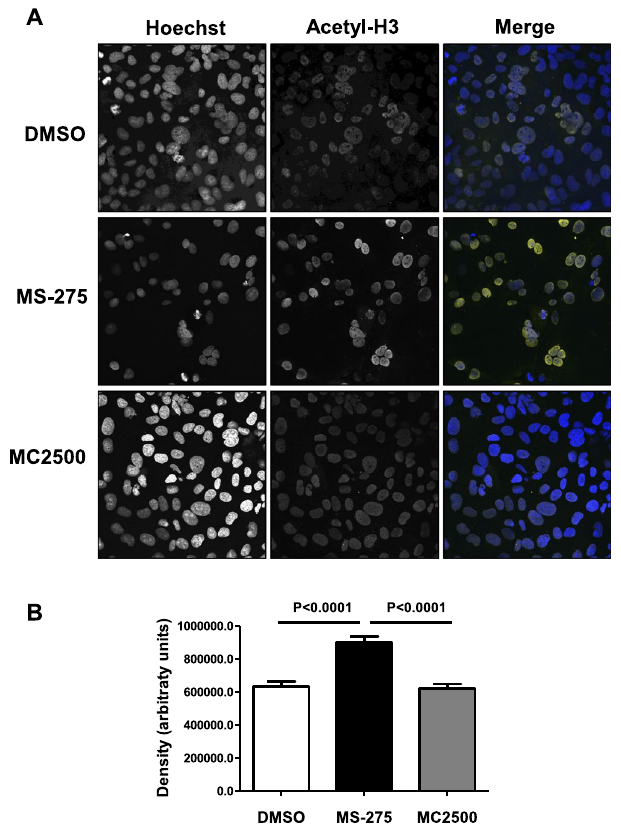
Figure 2. Treatment with MS-275 promotes nuclear histone H3 acetylation. ( A ) Confocal immunofluorescence analysis of MCs treated with DMSO, MS-275 (250 nM), MC-2500 (250 nM) for 12 h. Cells were fixed, permeabilized and stained with anti-acetylated histone H3 (yellow). Images were acquired by confocal microscopy. Nuclei were stained with Hoechst 33342 (blue). Data are representative of three independent experiments. ( B ) Quantification of the experiment shown in (A). The histogram shows fluorescence intensities of nuclear acetylated histone H3 staining quantified using the software ImageJ. Bars represent ± SEM. At least 400 nuclei were analyzed per condition. P < 0.05 was considered